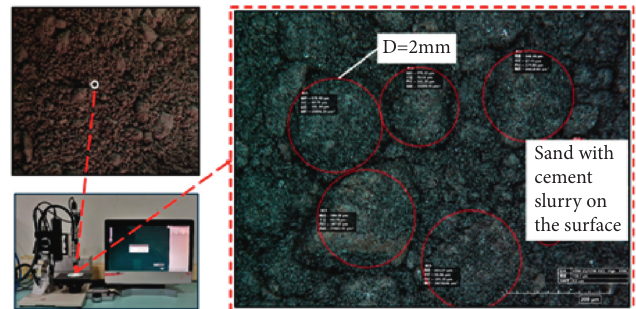
Figure 7: Sand observed by Leica DVM50C digital